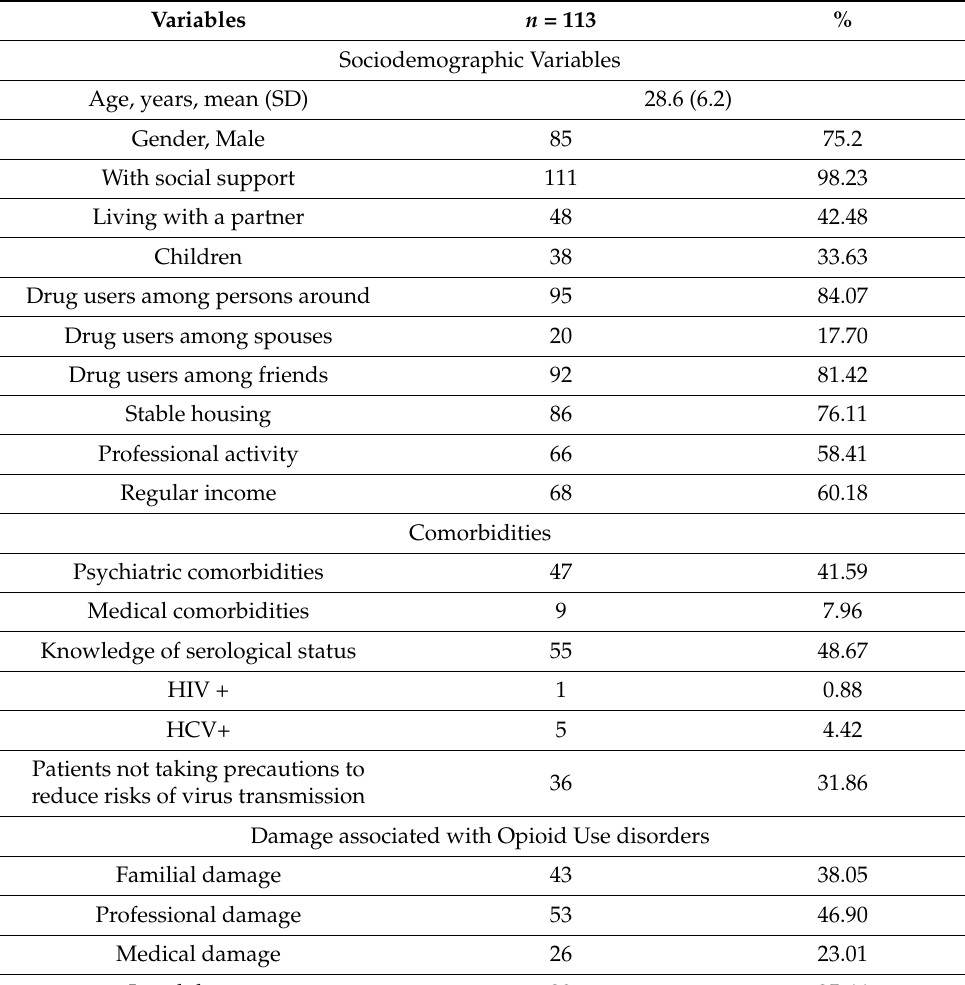
Table 1. Description of sociodemographic data at inclusion in the specialized